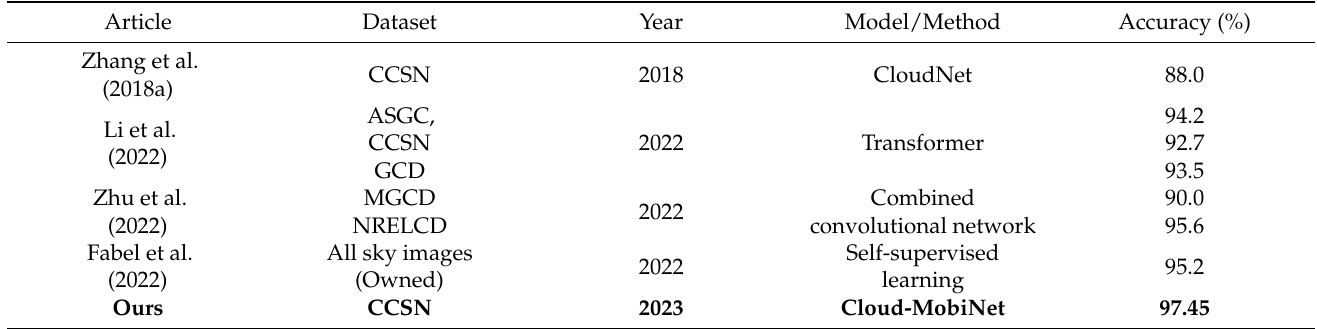
Table 4. Comparison of this study with the latest technological approaches in the